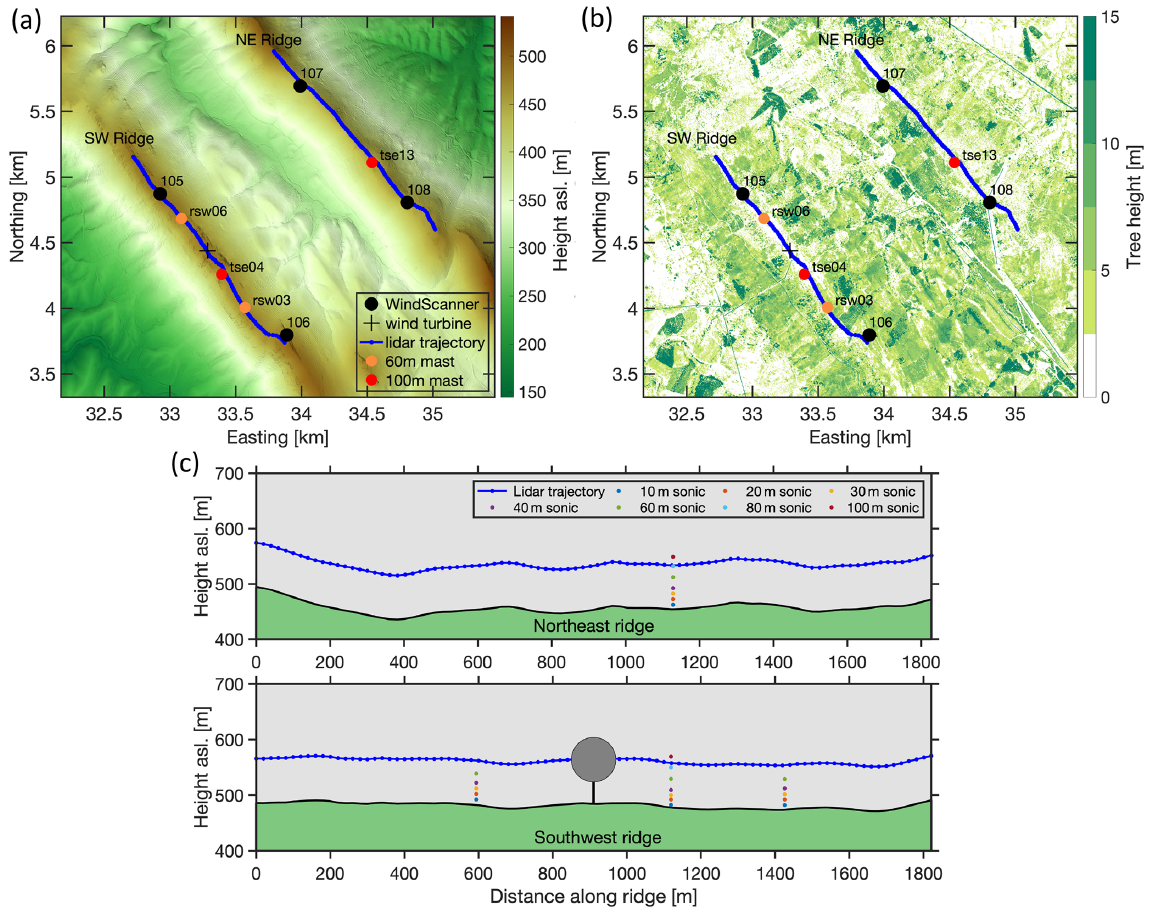
Figure 1. (a) Elevation map of the Perdigão site in the PT-TM06/ETRS89 coordinate system. (b) Tree height map. (c) View from the southwest of the ridges with lidar and sonic anemometer sampling positions and wind turbine at center of the southwest